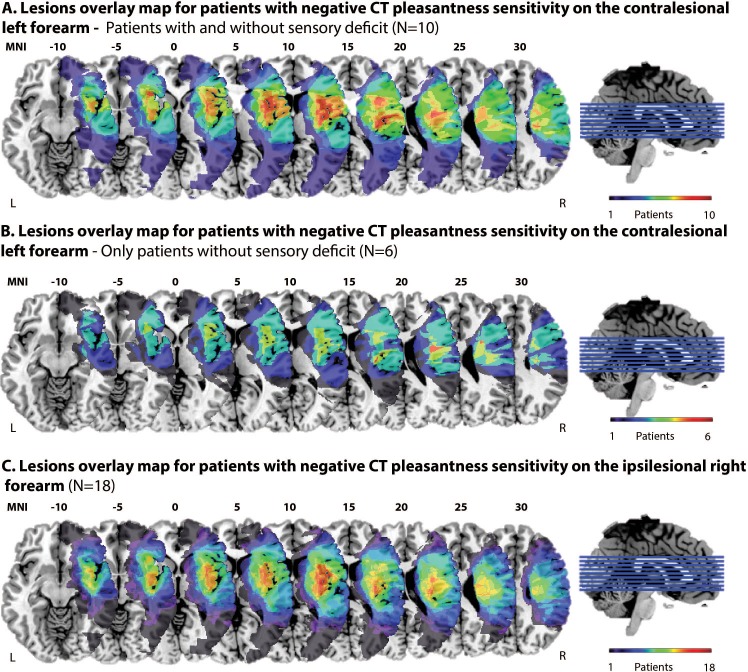
Lesions Overlaps.(A) Lesions overlap map for patients with negative CT pleasantness sensitivity on the left contralesional forearm, among all patients (N = 10). Out of the 10 patients that showed a negative CT pleasantness sensitivity on the contralesional forearm (among all patients, N = 35), 8 of them had a lesion to the rolandic operculum cluster (X = 48, Y=-9, Z = 15); and for the two remaining patients, one had a more focal deep lesions (amygdala, putamen, thalamus), that could still be on the posterior insula track; and the other had an insula lesion but more frontal. (B) Lesions overlap map for patients with negative CT pleasantness sensitivity on the left contralesional forearm, only in patients without sensory deficit (N = 6). When taking into account only patients without sensory deficit, out of the six patients that showed a negative CT pleasantness sensitivity on the contralesional forearm (among patients without sensory deficit, N = 25), five had a lesion to the posterior insula cluster (X = 38, Y=-12, Z = 12), and the other had a more focal deep lesion (amygdala, putamen, thalamus) (C) Lesions overlap map for patients with negative CT pleasantness sensitivity on the right ipsilesional forearm (N = 18). Out of the 18 patients with a negative CT pleasantness sensitivity on the ipsilesional forearm, 15 had a lesion of the anterior insula cluster (X = 45, Y = 3, Z = 8); and the three remaining had a lesion to the insula, but not on that specific cluster. An overlay heat map of participants’ lesions was calculated from all lesions and superimposed on the chi2bet template brain using MRICron (Rorden et al., 2007).